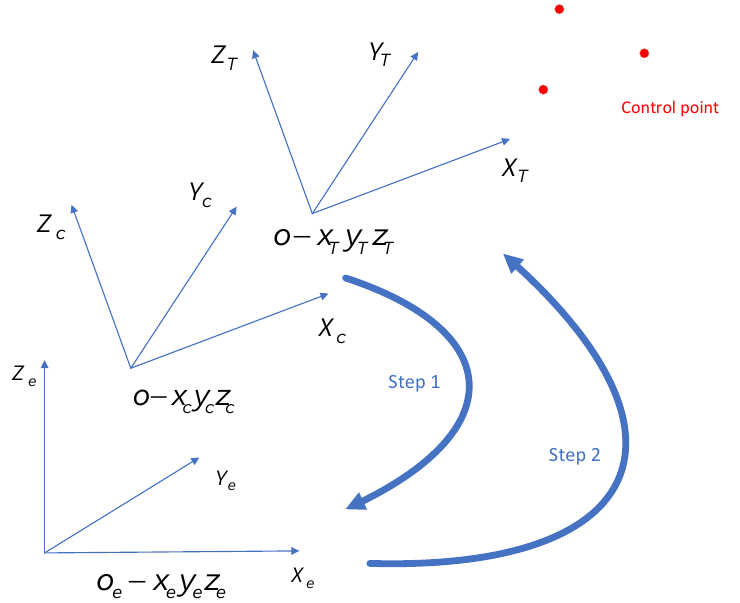
Figure 5. Location and attitude transform.